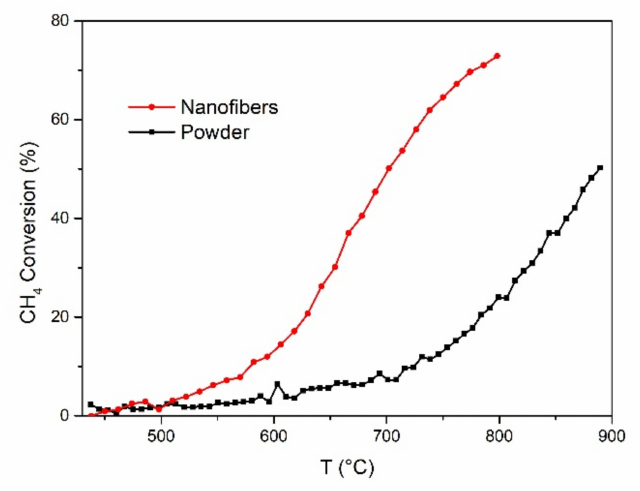
Figure 7. Catalytic activity in methane oxidation measured for LSM powders (black) and nanofibers